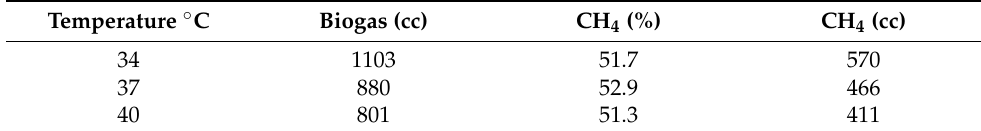
Table 3. Biogas, CH 4 % and methane produced from sludge.